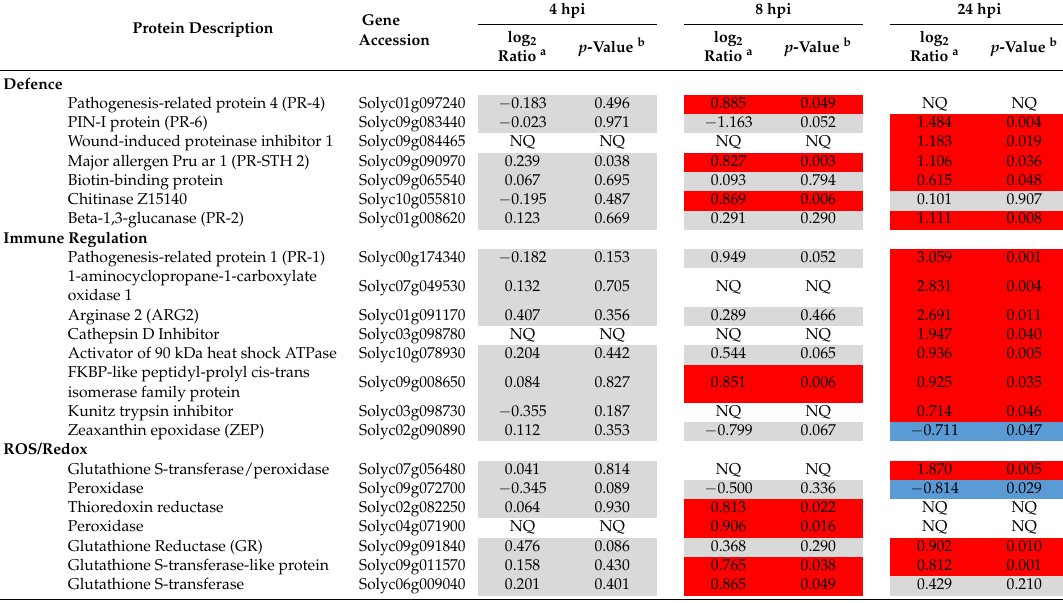
Defence Pathogenesis-related protein 4